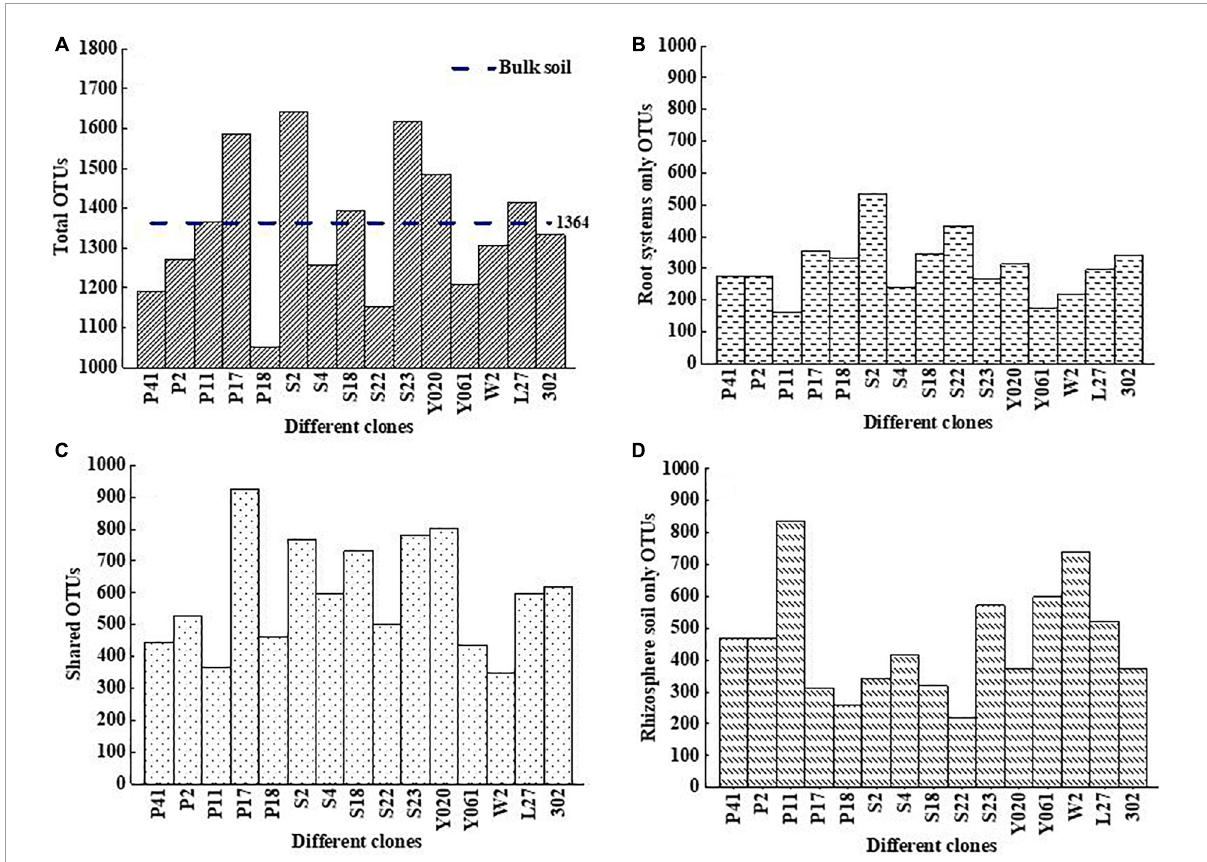
FIGURE4 Venn diagram of AMF OTUs number in different clones of Chinese fir plantations, the total OTUs (A) , root system only OTUs (B) , shared OTUs (C) , and rhizosphere soil only OTUs (D) , respectively. On the horizontal axis, S-NR represents bulk soil, R-represents root system, S-represents rhizosphere soil, and the subsequent number indicates